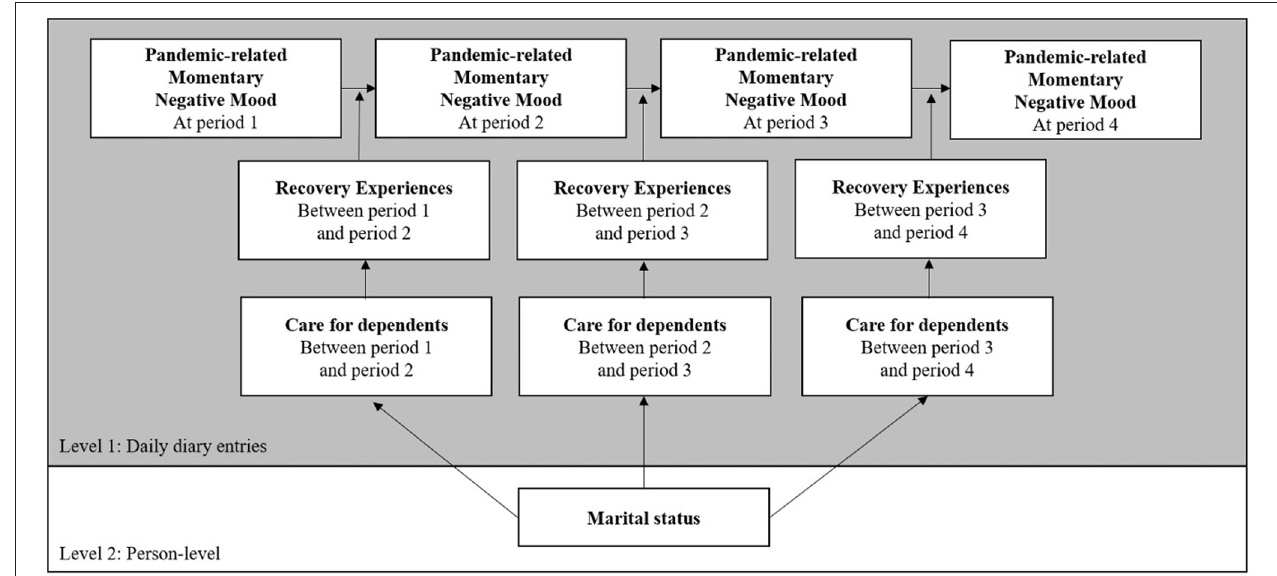
FIGURE 1 | The conceptual model of within-person reciprocal relationships among pandemic-related momentary negative mood and recovery experiences.